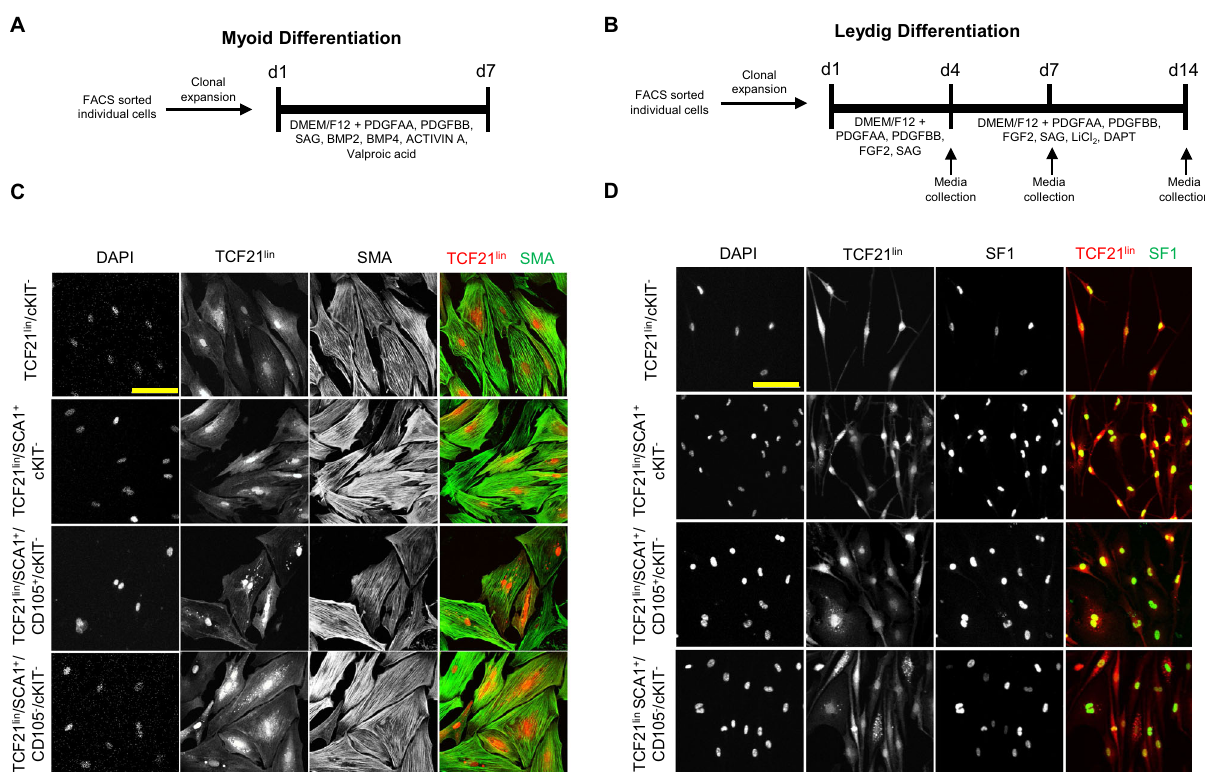
Fig. 2 The adult TCF21 lin cells are multipotent and can be directed to differentiate to Leydig and smooth muscle cells in vitro. Schematic representation of experimental timelines for myoid ( A ) and Leydig cell ( B ) directed differentiation. Gating strategy used for FACS is presented in Supplementary Fig. 2G. C Immuno fl uorescence staining of smooth muscle actin (SMA) in clonal TCF21 lin cells after 7 days of in vitro culture in the presence of differentiation media. Representative images of n = 13 technical replicates of TCF21 lin /cKit − , n = 6 technical replicates of TCF21 lin /SCA1 + /cKit − , n = 6 technical replicates of TCF21 lin /SCA1 + /cKit − /CD105 + , and n = 14 technical replicates of TCF21 lin /SCA1 + /cKit − /CD105. Scale bar: 100 μ m for all images in the panel. D Immuno fl uorescence staining of steroidogenic factor 1 (SF1) in clonal TCF21 lin cells after 14 days of in vitro culture in the presence of differentiation media. Representative images of n = 19 technical replicates of TCF21 lin /cKit − , n = 17 technical replicates of TCF21 lin /SCA1 + /cKit − , n = 12 technical replicates